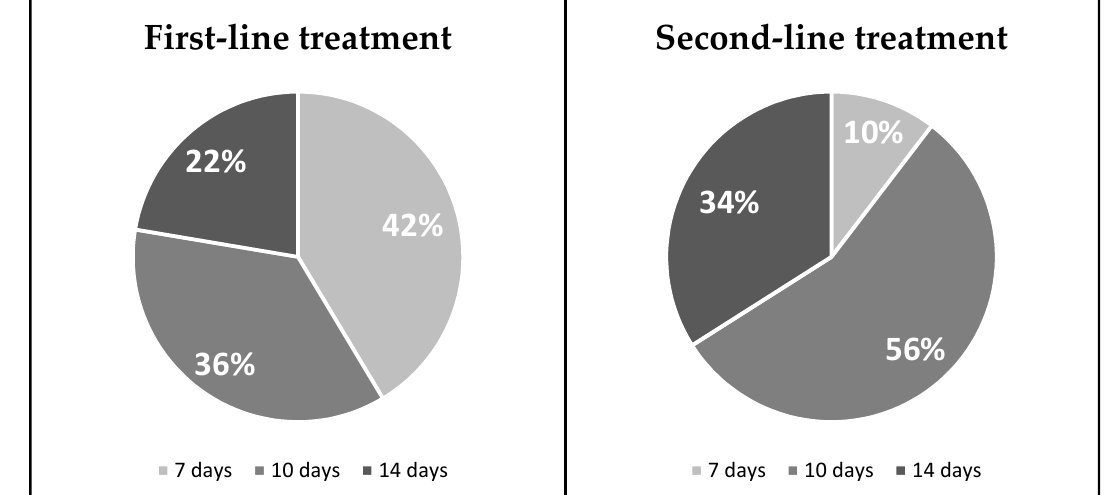
Figure 3. Duration of first and second-line treatments. Significant statistical differences have been found between treatment durations: χ 2 test = 115.9; p < 0.001.